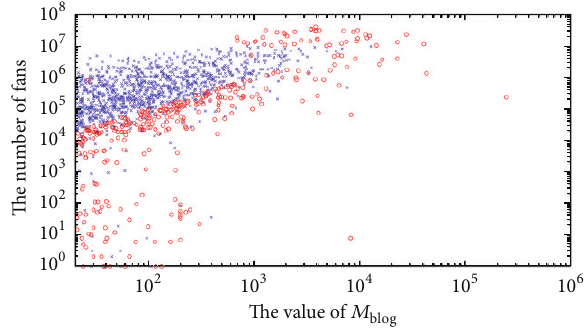
Figure 6: The microbloggers whose 𝑀 the red nodes represent the VIP users.